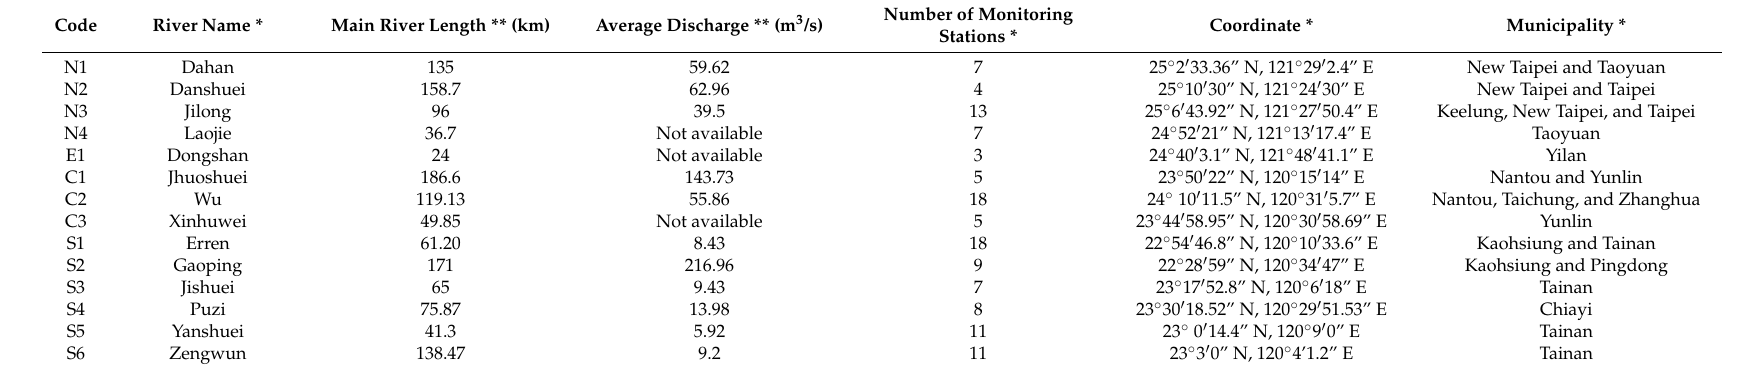
Table 1. Representative river water monitoring